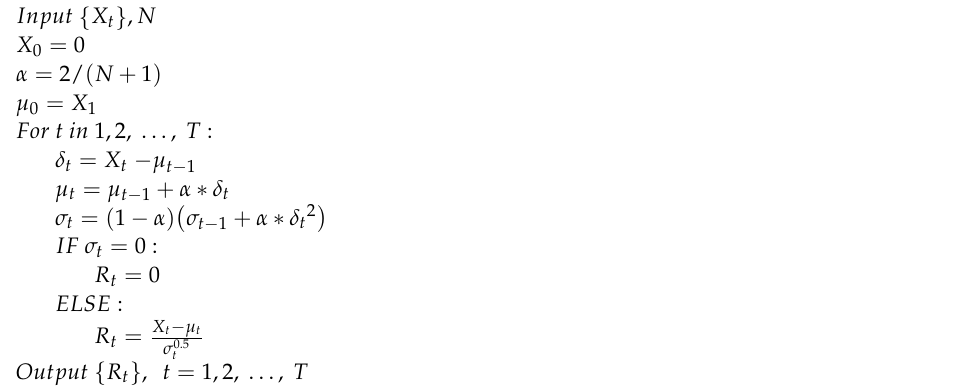
Algorithm 3. Dynamic perceived risk perception by exponentially weighted moving average and exponentially weighted moving standard deviation with window size as N.